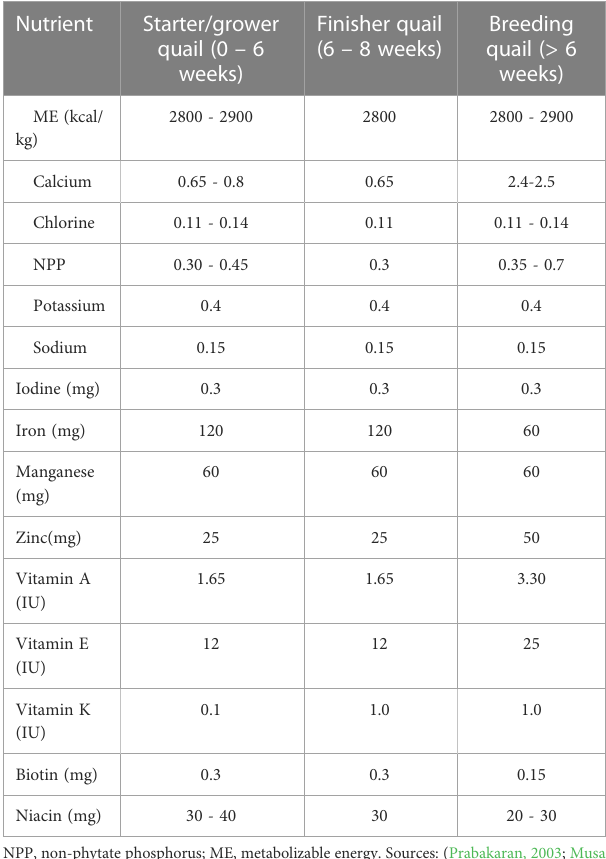
TABLE 2 Energy, mineral and vitamin requirements of quails (% DM, unless otherwise